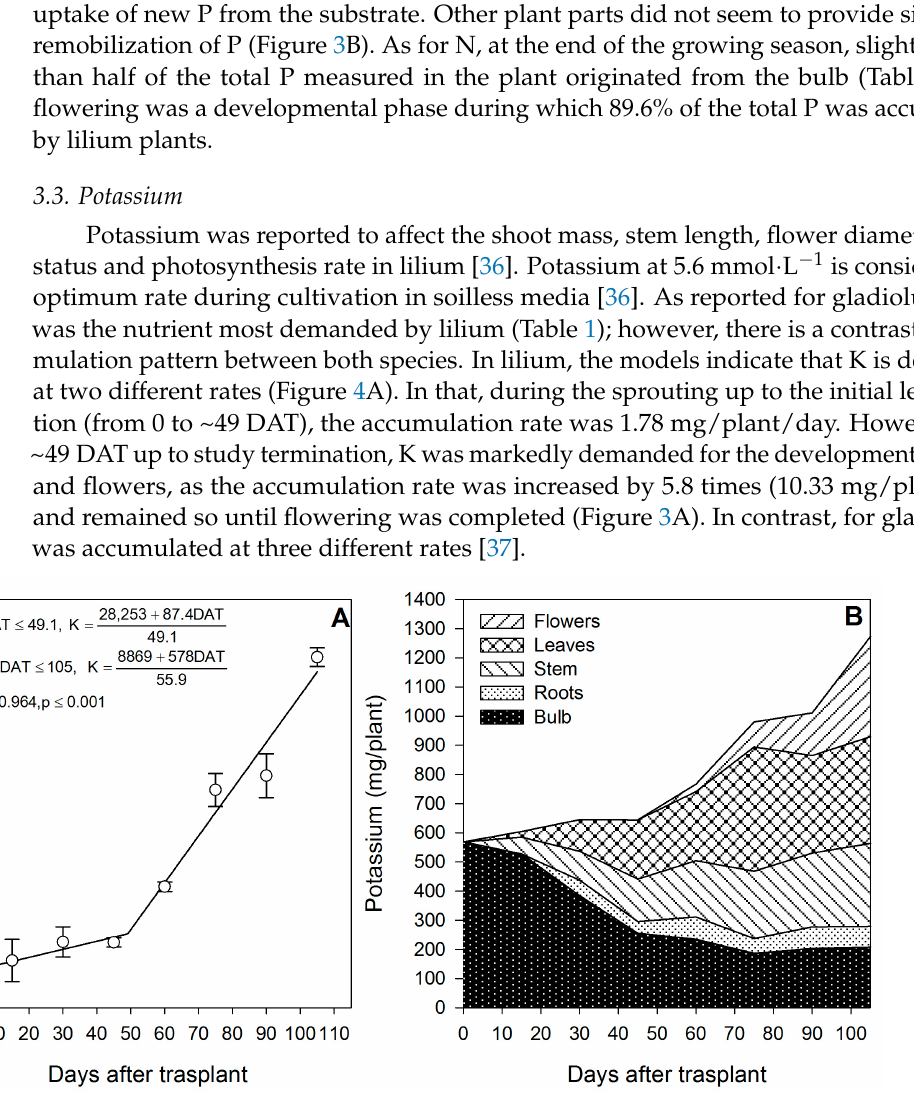
Figure 4. Potassium accumulation in lilium: ( A ) Segmented analysis of potassium accumulation over the growing season; ( B ) Potassium distribution in the lilium plant parts. Day 0 = transplant day, days 0 to 15 = sprouting and initial vegetative growth, days 15 to 60 = rapid vegetative growth plus flower buds formation, days 60 to 105 = blooming. DAT = days after transplant.